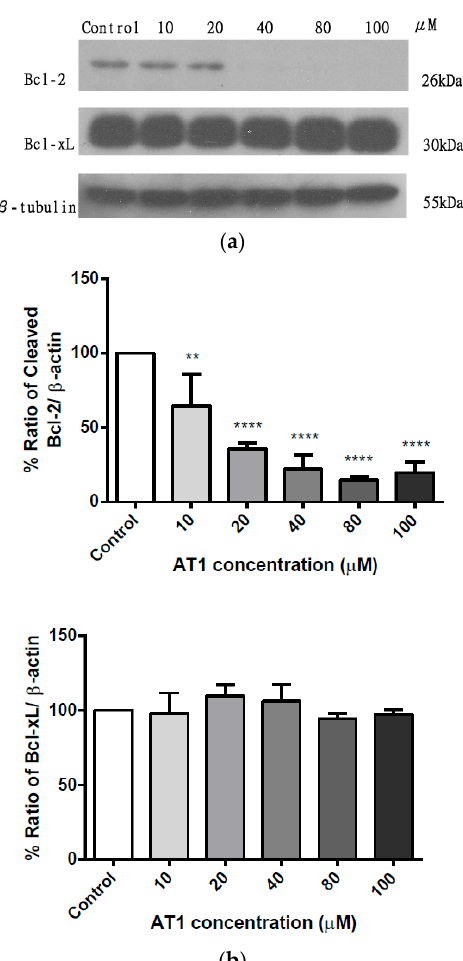
Figure 9. The effects of various concentrations of AT-I on the expression levels of pro-survival Bcl-2 family proteins in HT-29 cells were assessed by western blotting, after cells were treated with AT-I for 48 h. The control group was not treated with AT-I. The total protein concentration of each sample was determined and normalized. β -tubulin was used as a loading control in all western blot experiments. The intensity of each band was quantified by the ImageJ image processing program. ( a ) Western blot images of Bcl-2, Bcl-xL, and β -tubulin. The images are representative of three independent experiments. ( b ) Each bar chart presents the percentage ratio of each investigated protein to β -tubulin. Data are shown as mean ± SD, n = 3. Significant differences are indicated by ** p < 0.01 and **** p < 0.0001 as compared with the control group.